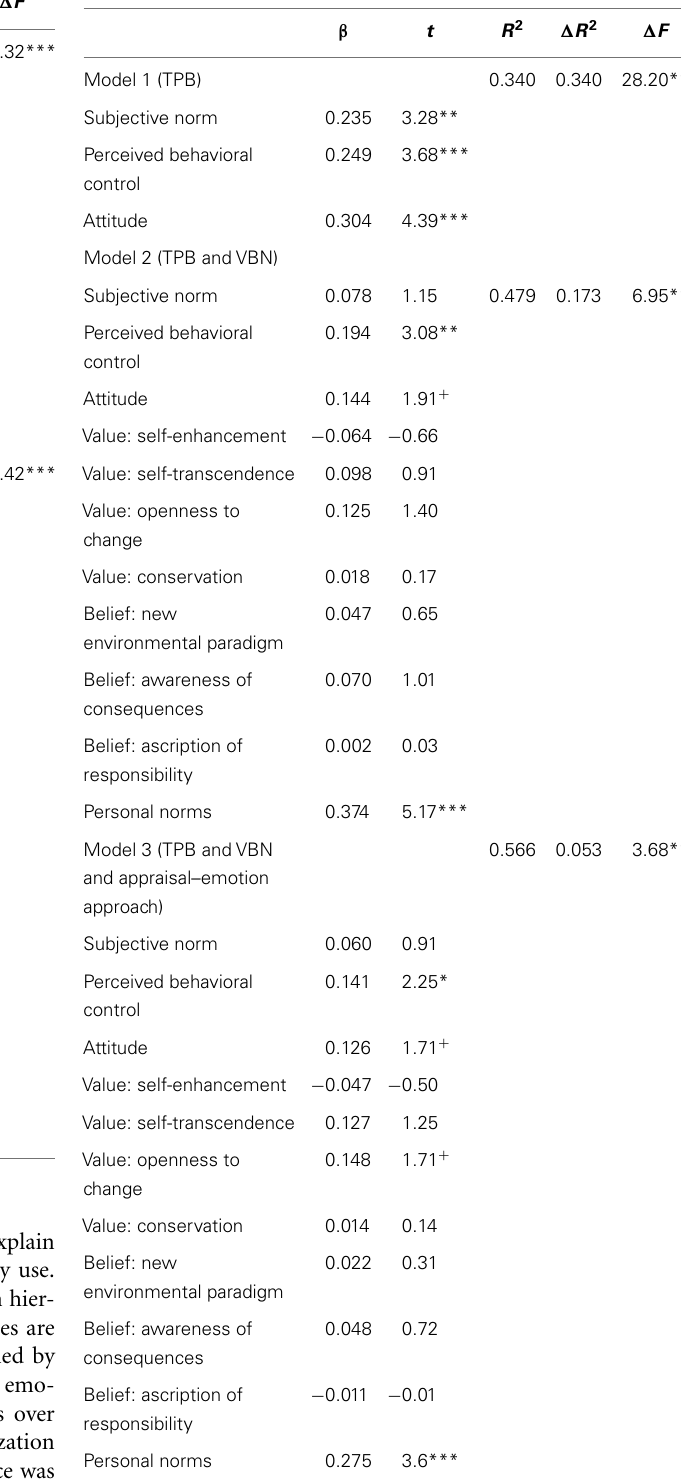
Table 7 | Hierarchical regression results forTPB (model 1), the combined variables fromTPB andVBN (model 2), and the combined variables forTPB,VBN, and the appraisal–emotion approach (model 3, N = 168)